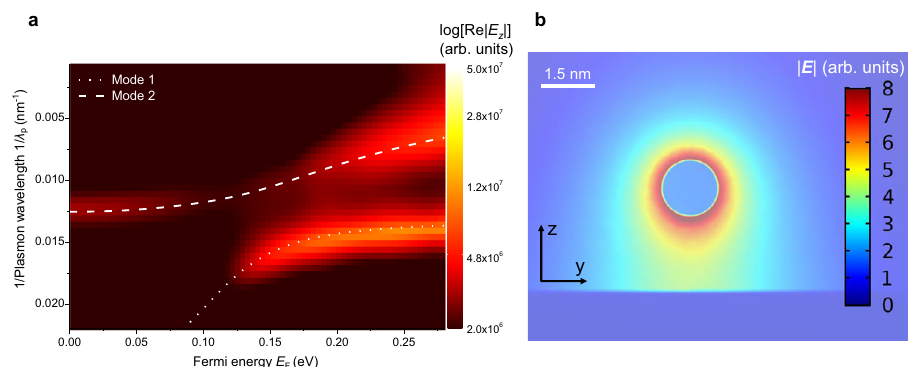
Fig. 4 Numerical simulation of the plasmon modulation in the heterostructure. a Fourier transform amplitude of the radial electric fi eld, |Re( E z )| at the SWNT surface. |Re( E z )| is plotted on a logarithmic scale. Theoretically predicted plasmon dispersion is also shown for comparison (white dashed line: mode 1, white dotted line: mode 2). b Simulated electric fi eld amplitude | E | of the hybrid plasmon modes at a plasmonic peak position at an excitation wavelength of 10.6 μ m and a Fermi energy of 0.16 eV. The plasmon modes are excited by a z-directed electric point dipole mimicking the tip at the end of the nanotube at a height of 140 nm. The transverse electric fi eld is largely con fi ned within a few nanometers around the nanotube, which is about 1/1000 of λ = 10.6 μ m. Source data are provided as a Source Data fi 0